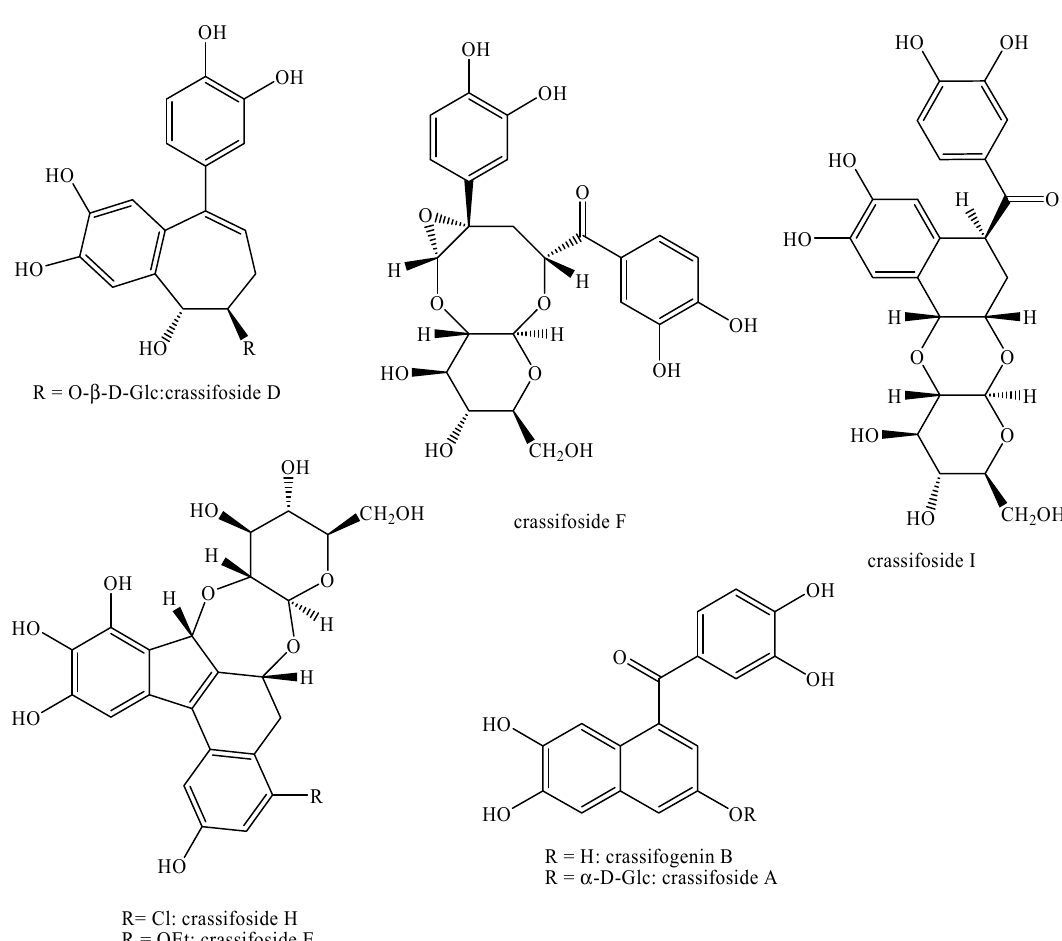
Figure 10. Isolated nor -lignans in the plant kingdom—part 9.